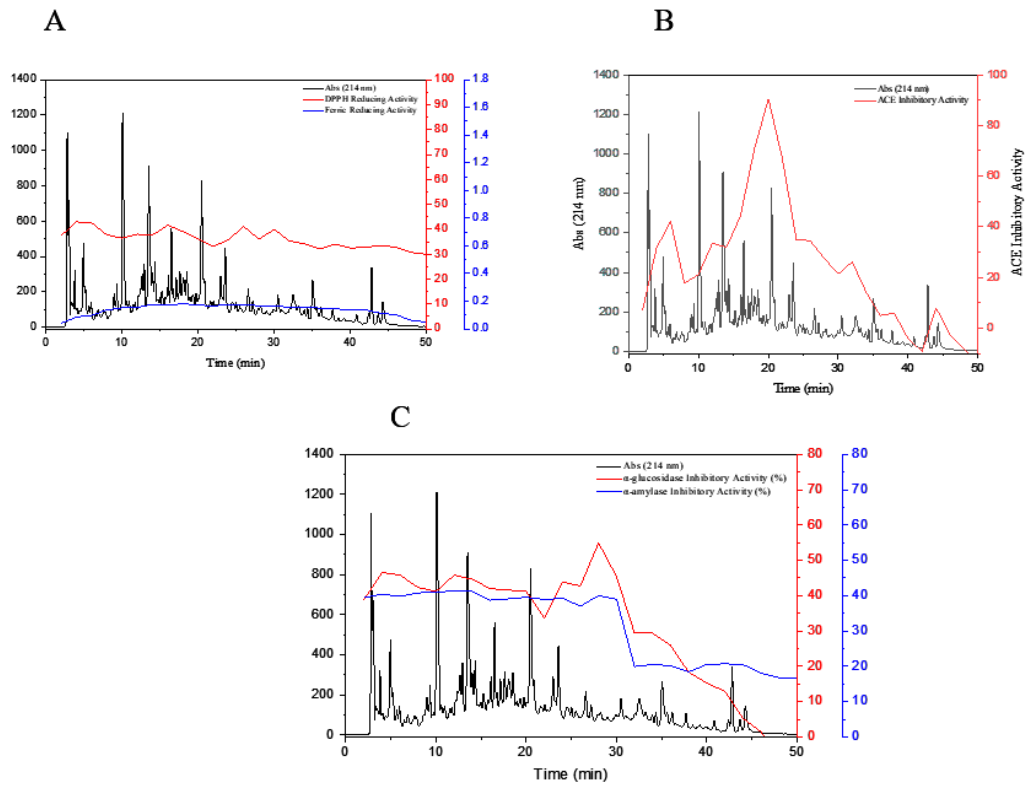
Figure 7. Reversed-phase chromatographic separation of F(40–44) and F(45–49) from SEC and after in vitro gastrointestinal digestion. Fractions were automatically collected and assayed for their DPPH scavenging activity and ferric-reducing power ( A ), ACE-inhibitory activity ( B ), and α -amylase-inhibitory activity and α -glucosidase-inhibitory activity ( C ). Fractions 19 and 20 obtained from RP-HPLC were selected for sequencing and identification.